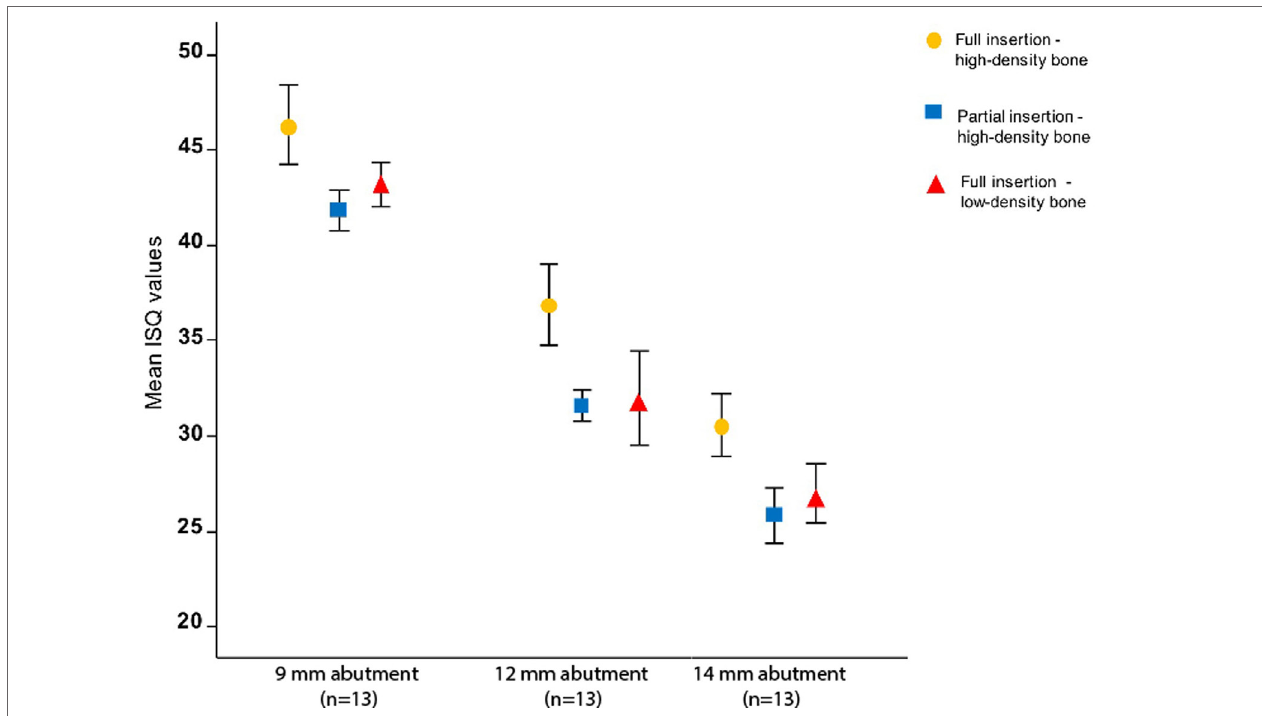
FIgURe 4 | The influence of abutment length, bone density, and insertion on implant stability quotient (ISQ) in vitro. The mean ISQ values for high-density bone configurations ( n = 5) and low-density bone configuration ( n = 3) together with the SDs are plotted for different abutment lengths and artificial bone densities. ISQ values decrease significantly with increase in abutment length ( p < 0.001), partial insertion ( p = 0.001), and reduced bone density ( p = 0.024). ISQ measurements of low-density partially inserted implants are missing due to an interaction between low density and partial insertion ( Figure 1c